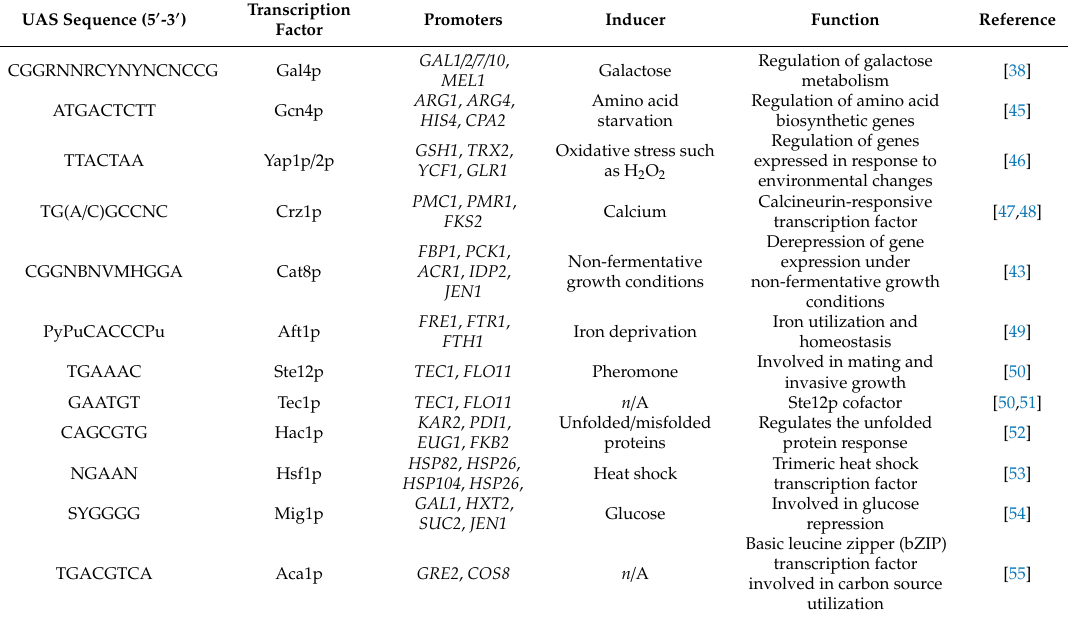
Table 1. Common UASs and URSs in S. cerevisiae